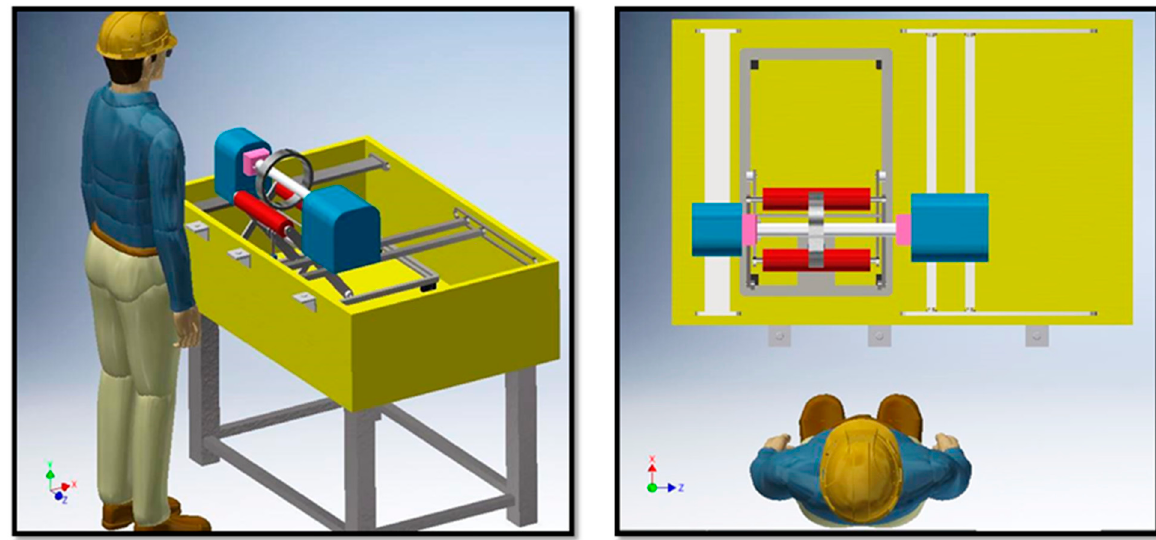
Figure 9. The operator position for a standard equipment using an auxiliary device.